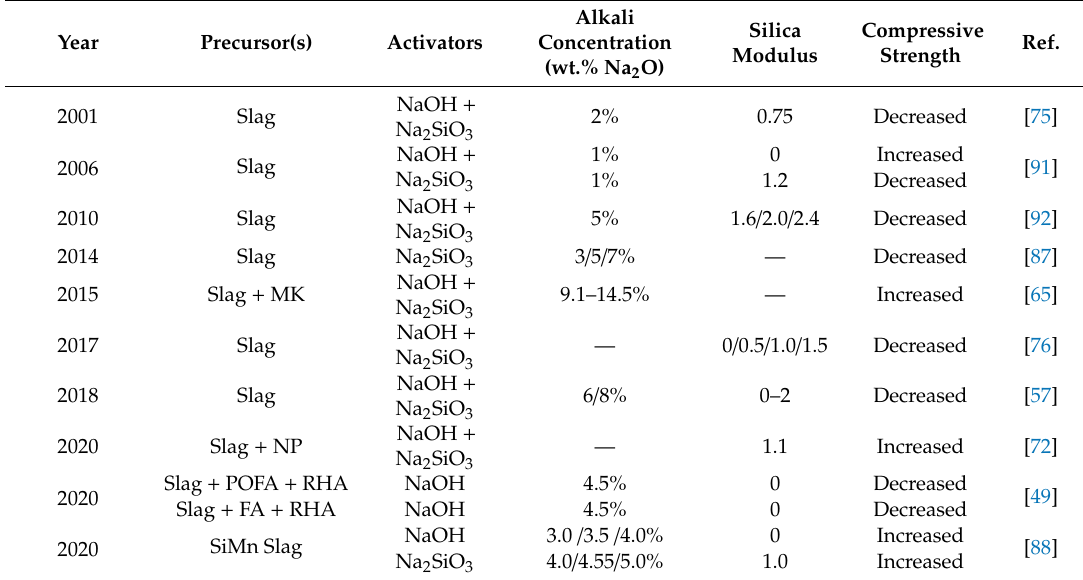
Table 1. Activators composition and silica modulus a ff ecting carbonation resistance of